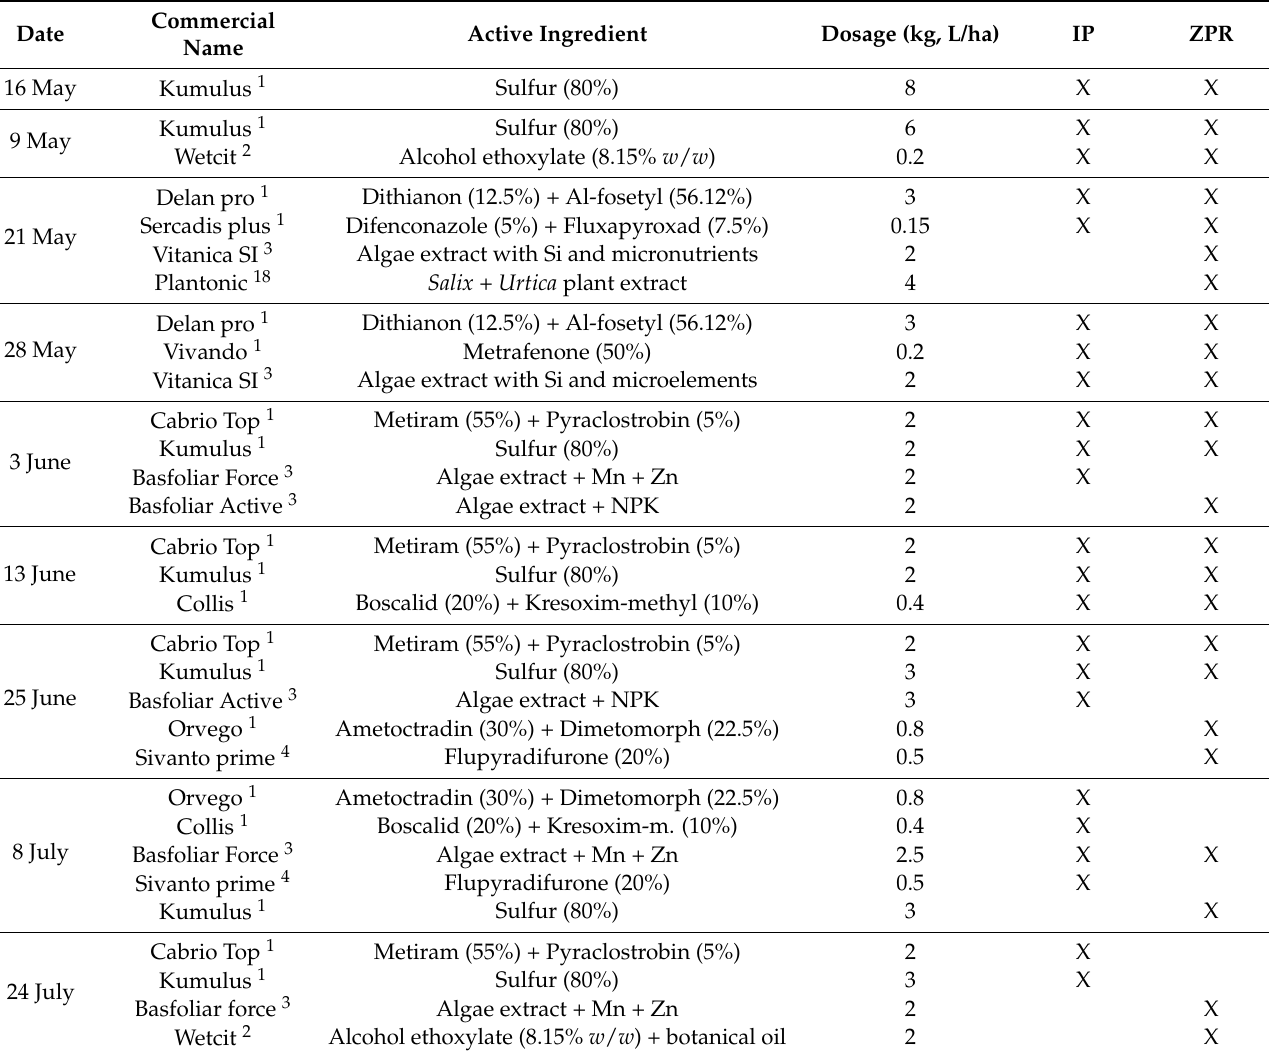
Table 1. Spray program for the Pinot Gris vineyard in the 2021 season at integrated (IP) and 0-pesticide residue (ZPR) grape protection systems. Preparation was applied if marked with